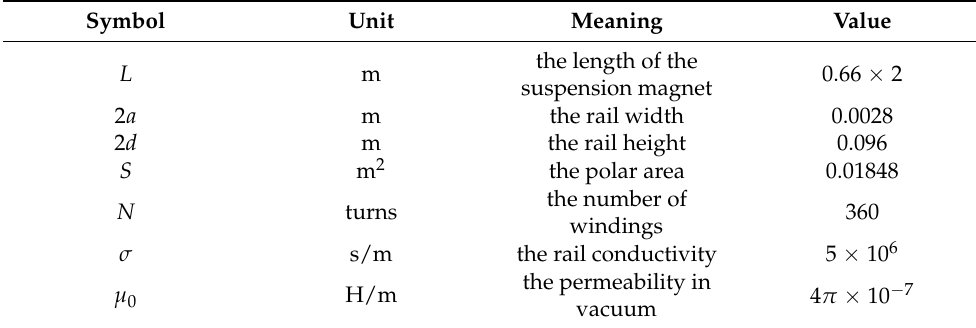
Figure 3. The equivalent magnetic circuit model of the single suspension magnet model. Table 1. Meanings, values, and units of